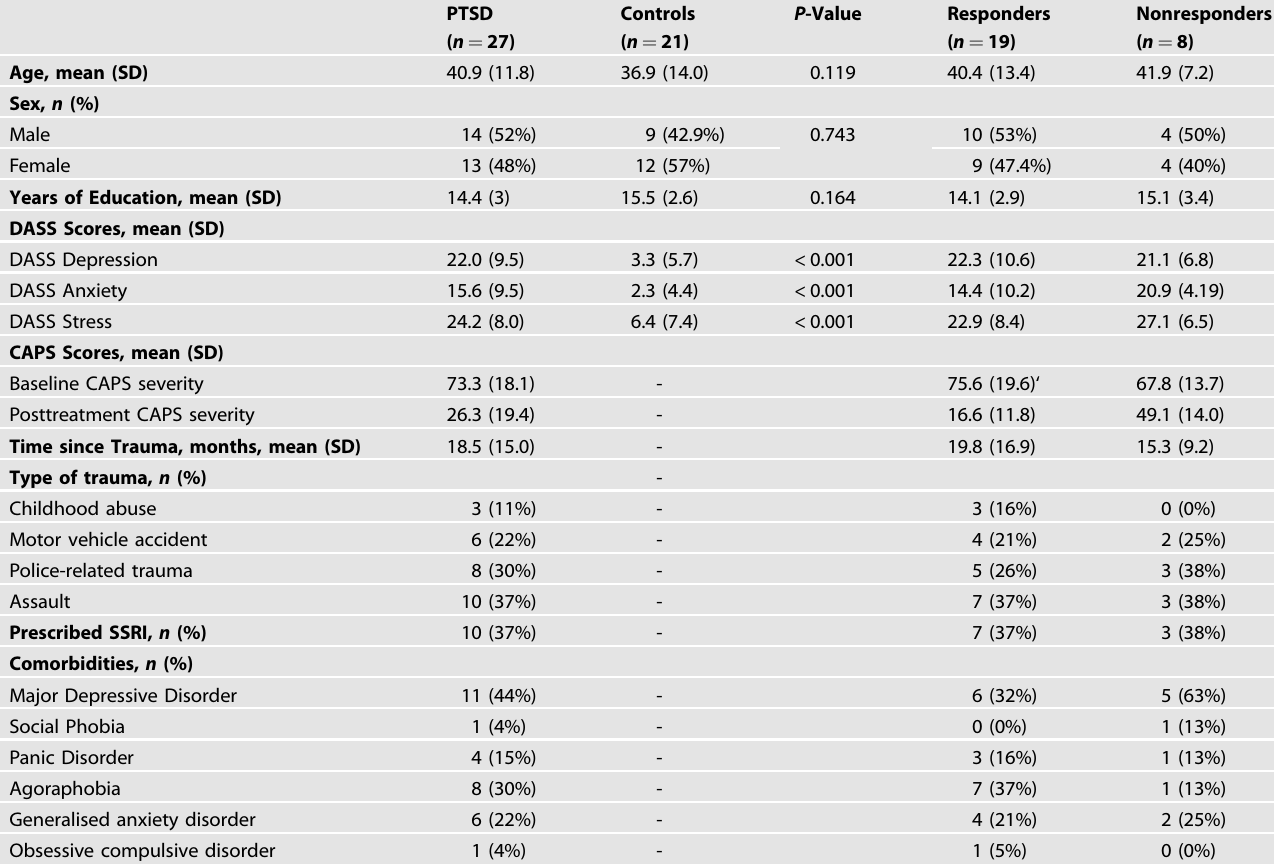
Table 1. Participant